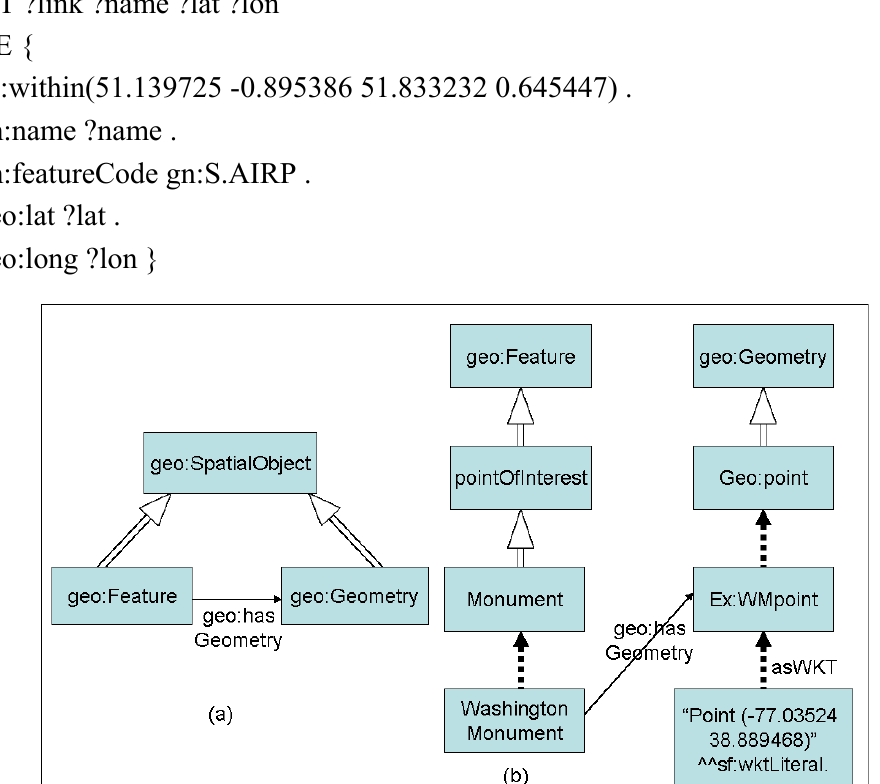
Figure 8. Example of describing geographic entities in GeoSPARQL [23]. ( a ) Generic structure; ( b ) example for a